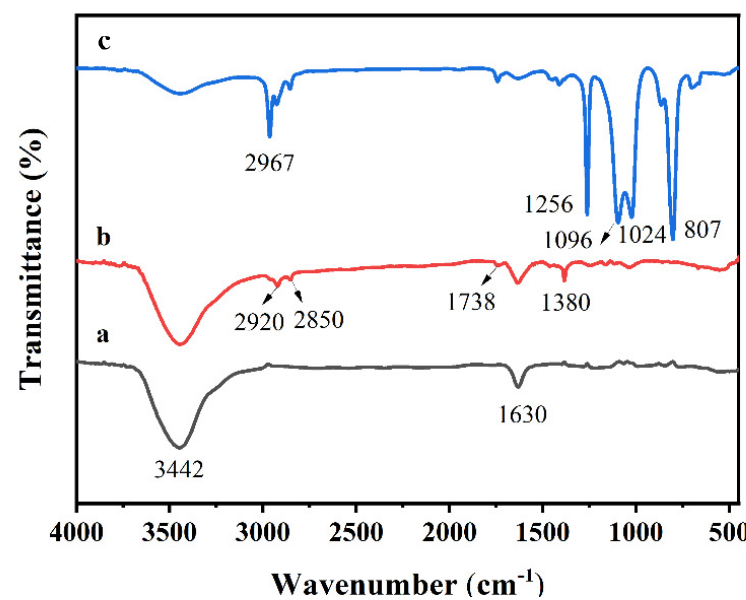
Figure 3. FTIR spectra of CF ( a ), E-CF ( b ), and A-CF ( c ).